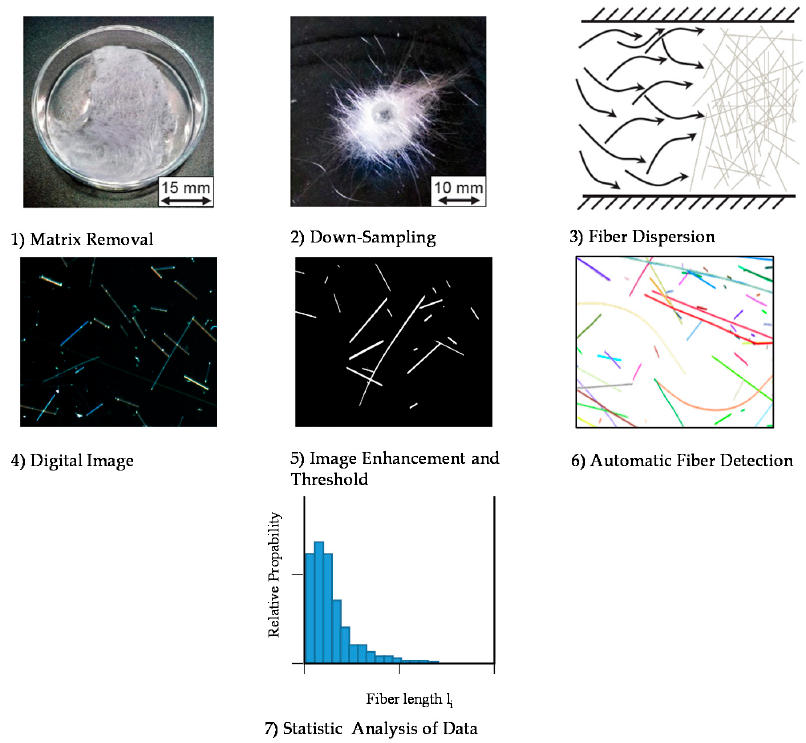
Figure 4. Overview of the developed methodology (Epoxy plug method) for fiber length analysis after Goris adapted from [17].